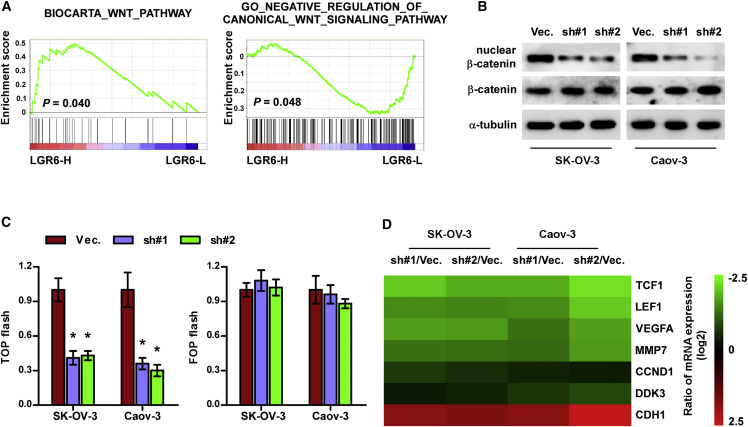
Silencing LGR6 Inhibits Wnt/β-Catenin Signaling(A) GSEA analysis showed that LGR6 expression level was positively correlated with Wnt/β-catenin signaling. (B) Western blot analysis of total and nuclear expression of β-catenin in the indicated cells. p84 was used as loading control. (C) The TOP/FLASH reporter activity in the indicated ovarian cancer cells. Error bars represent the mean ± SD of three independent experiments. *p < 0.05. (D) Real-time PCR analysis of TCF1, LEF1, VEGFA, MMP7, CCND1, DDK3, and CDH1 in the indicated cells.